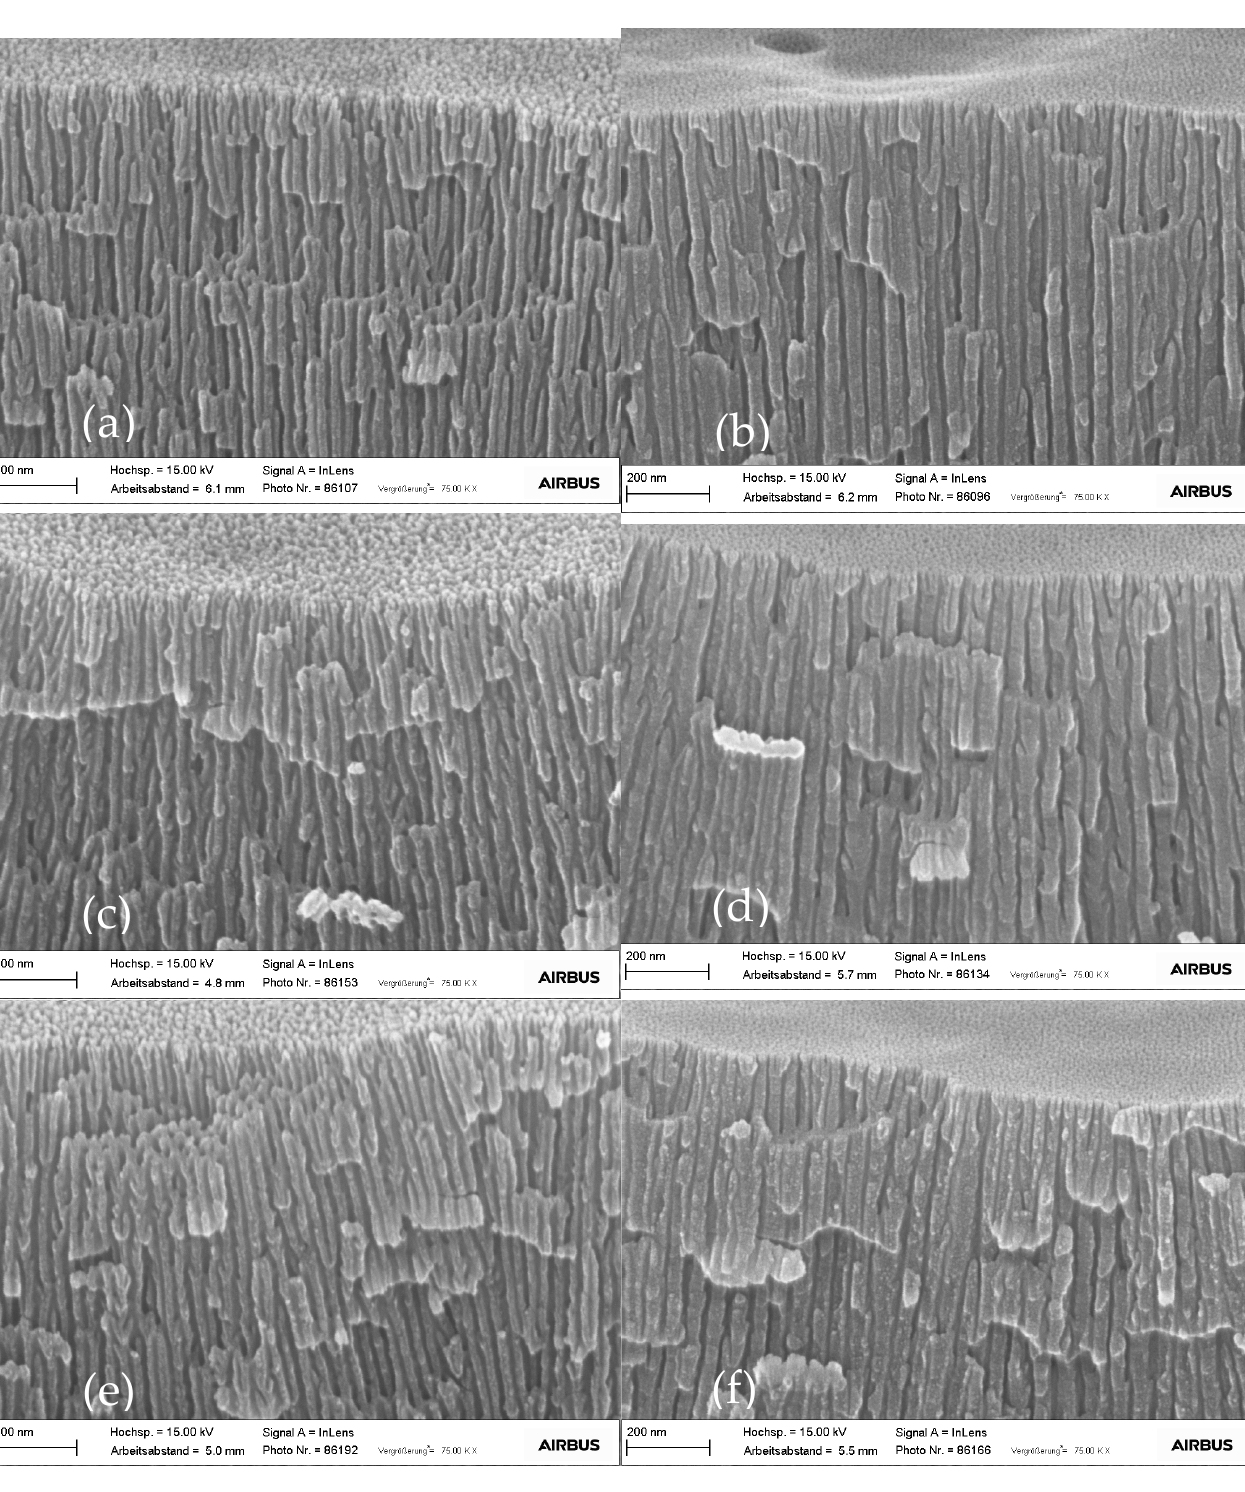
Figure 5. FE-SEM micrographs in cross-section of ( a ) SAA 14 V 45 °C; ( b ) SAA 20 V 37 °C; ( c ) TSA 14 V 55 °C; ( d ) TSA 20 V 37 °C; ( e ) T + SA 14 V 55 °C; ( f ) T + SA 20 V 37 °C.